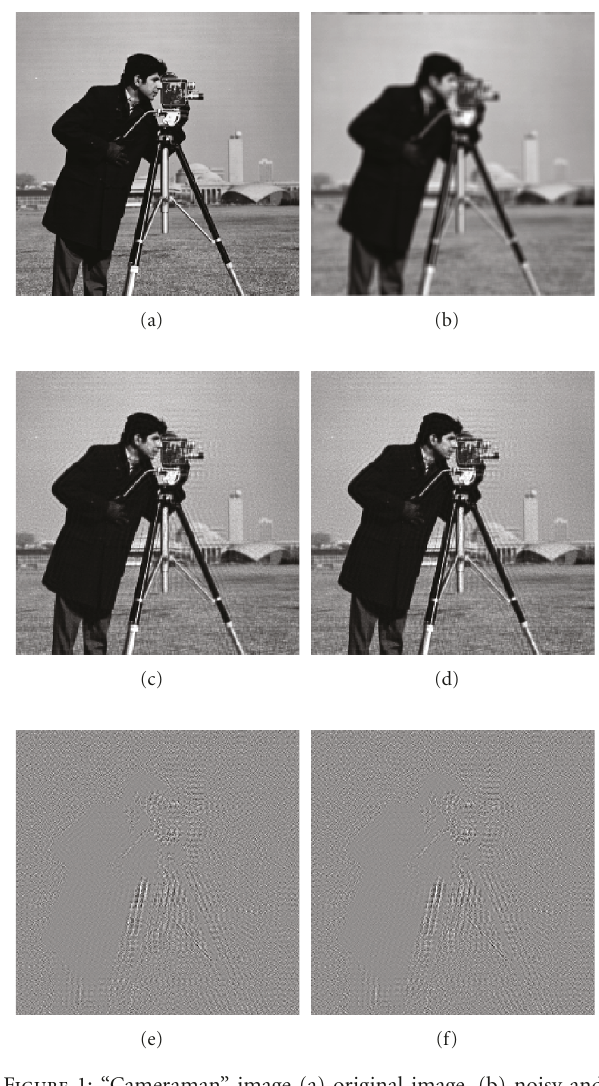
Figure 1: “Cameraman” image (a) original image, (b) noisy and blurred image; PSF 5 × 5 Box-Car, BSNR = 40dB, (c) restored image by MAPE corresponding to maximum SNR (348 iterations), (d) restored image by AAMAPE correspondsing to maximum SNR (201 iterations), (e) residual corresponding (c), and (f) residual corresponding